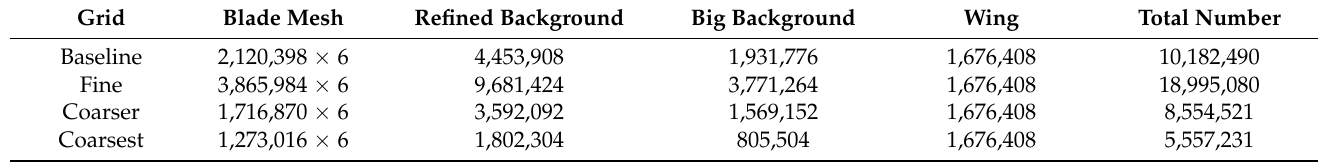
Figure 6. Normal force coefficient comparison of the four grid systems. ( a ) r/R = 0.85. ( b ) r/R = 0.9. Table 1. The number of grid elements in the various grid systems for hovering height